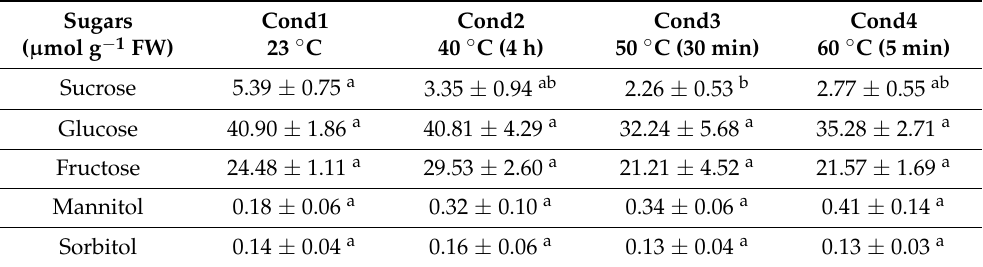
Table 2. Concentration of sugars ( µ mol g − 1 FW) detected in P. halepensis EMs, collected at proliferation phase, induced under different